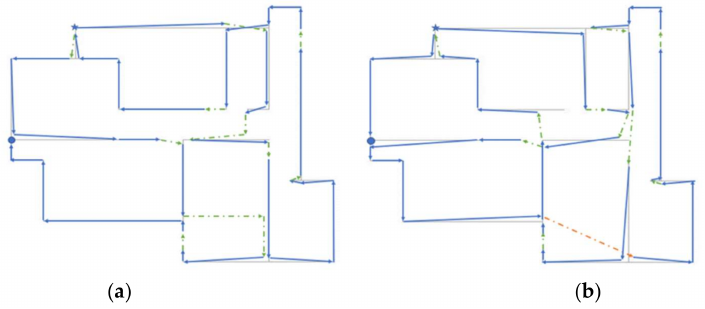
Figure 11. Example 4: 31-wall flat. ( a ) Best solution obtained for rectangular movements with T = 19.5. ( b ) Best solution obtained for diagonal movements permitted with T = 18.27491. Table 10. Coordinates and wall connectivities for Example 4 (31-wall